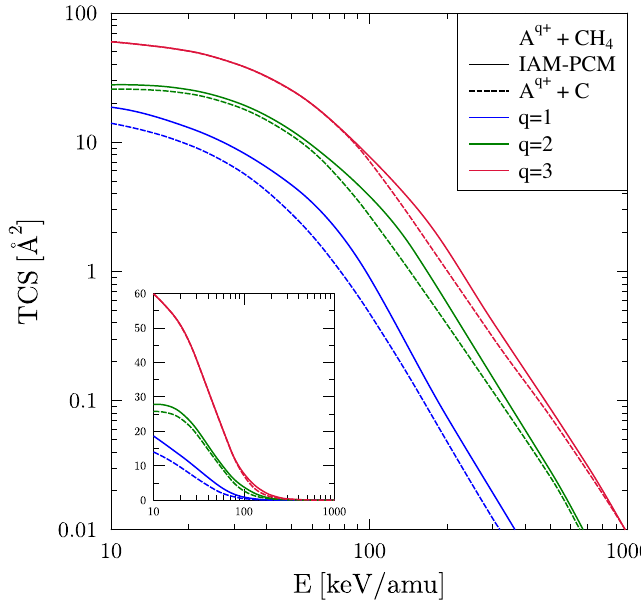
Figure 7. Net electron capture cross sections as functions of impact energy for collisions of protons, He 2 + , and Li 3 + ions with methane (CH 4 ) calculated in the IAM-PCM are compared to net capture from carbon atoms (short dashed lines) as calculated by the TC-BGM (cf. red curves in Figure 1). The top curve pair (in red) is for Li 3 + projectiles, the middle curve pair (in green) for He 2 + projectiles and the bottom pair (in blue) for proton